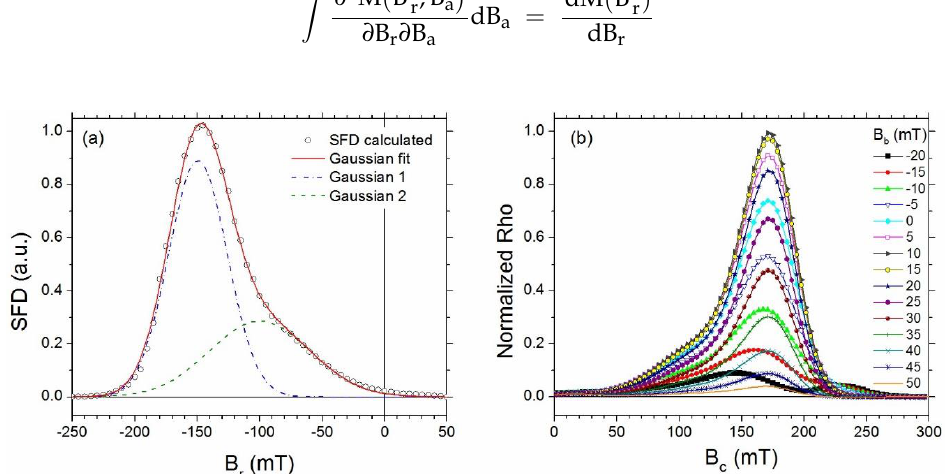
Figure 7. ( a ) Projection of the switching field distribution (SFD) onto the Br axis obtained by integrating over Ba. ( b ) Rho distribution plots for constant values of interaction field, B b , from −20 mT to +50 mT.